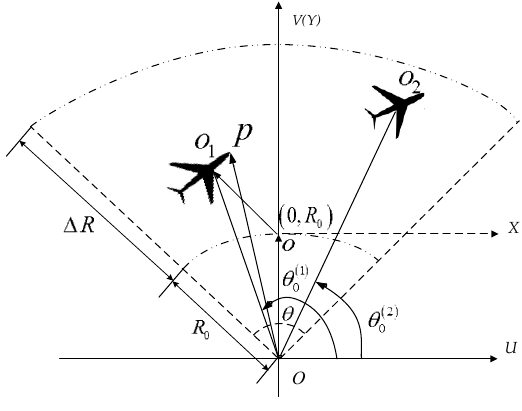
Figure 1. MAF geometry for the narrowband radar.